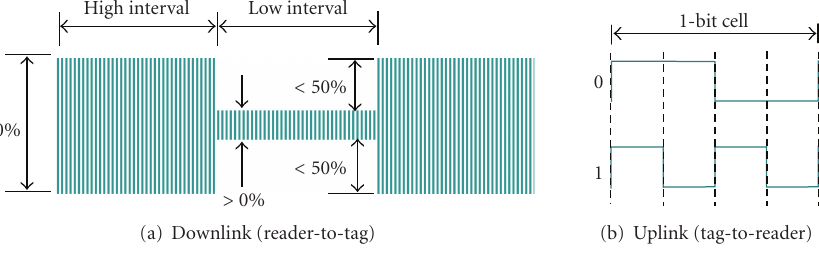
Figure 2: RFID bit signal waveforms.